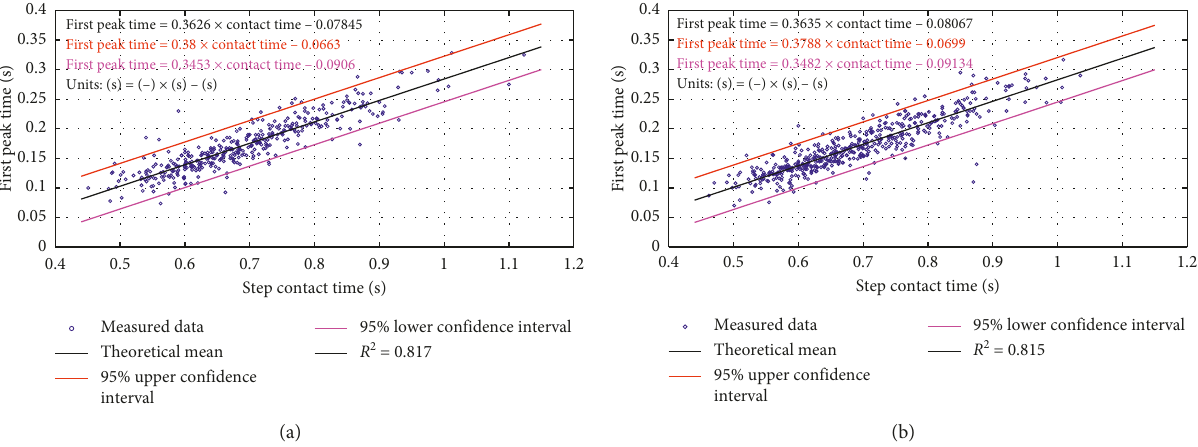
Figure 4: Statistical relationship between step contact time and first peak time. (a) Right footfall; (b) left footfall.